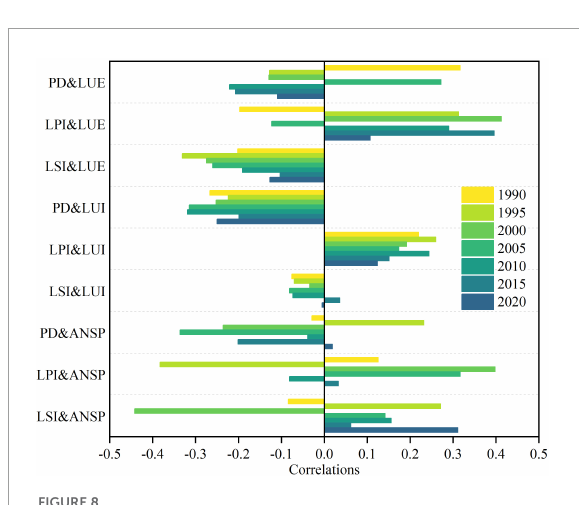
FIGURE8 The temporal patterns of trade-offs/synergies between land use dominant and recessive